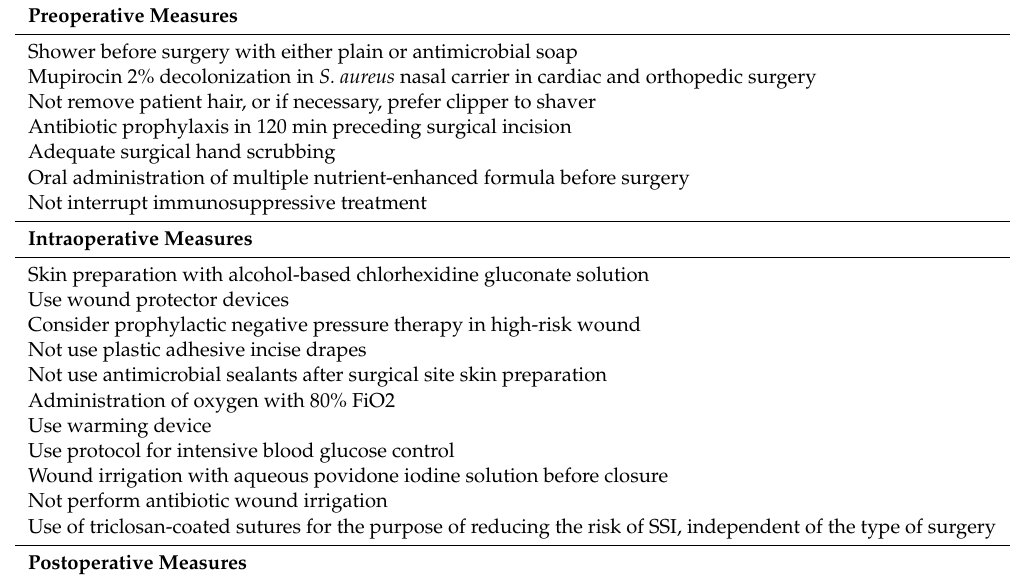
Table 4. World Health Organization recommendations for SSI prevention, 2016 version.